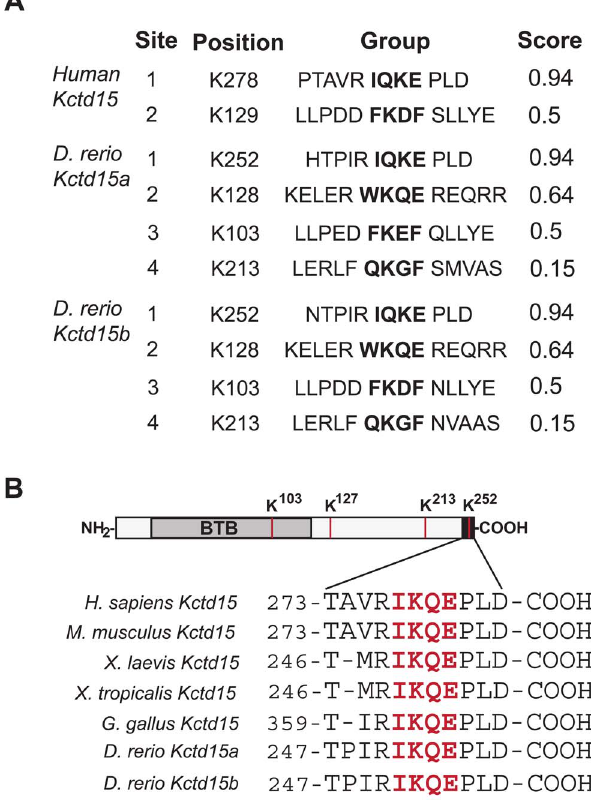
Figure 1. SUMOylation Motif in Kctd15. (A) SUMOylation sites in human KCTD15, and zebrafish Kctd15a and Kctd15b predicted by the SUMOplot Predictor Program, http://www.abgent.com/tools/. (B) Dia- gram of the BTB-containing protein zebrafish Kctd15. The different Lysine targets of SUMO are indicated in red. The C terminus of Kctd15 (black) harbors the highest confidence SUMO Interacting Motif (SIM). Sequence of the C-terminal region is shown with the SIM in red, demonstrating conservation between